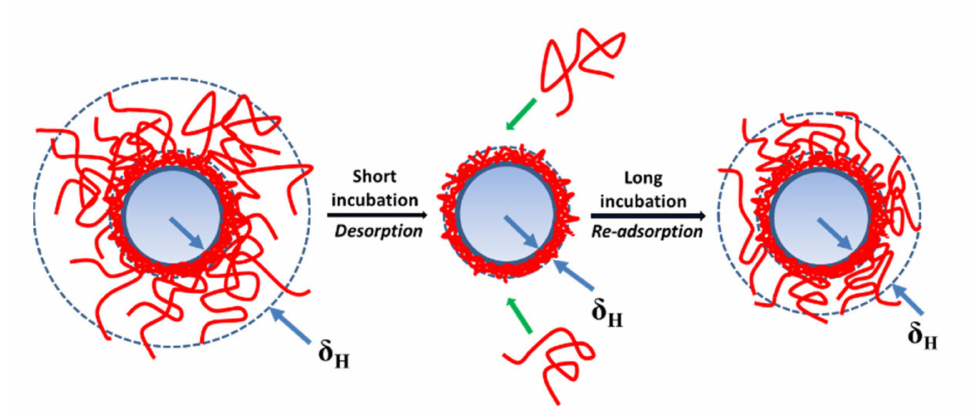
Figure 5. The polycation PTMA5M behaviors on the PSL colloidal particles with opposite charge in the long